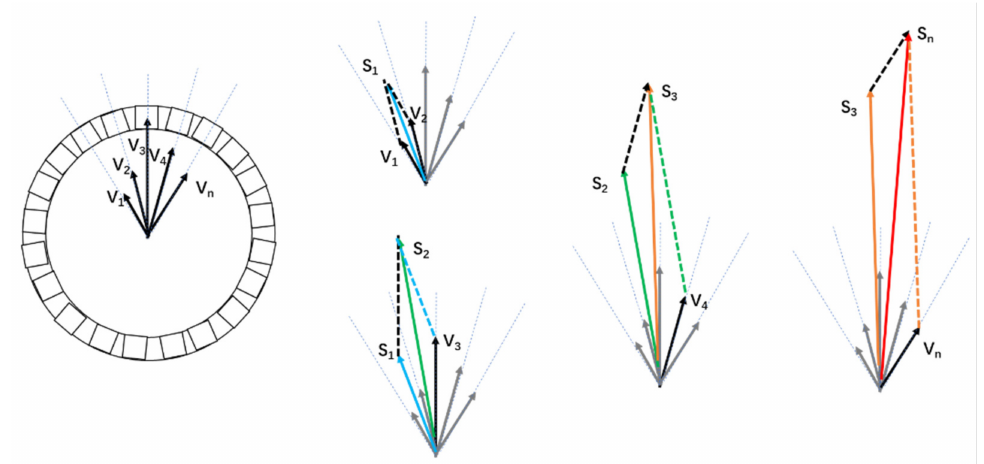
Figure 6. Illustration of the VA